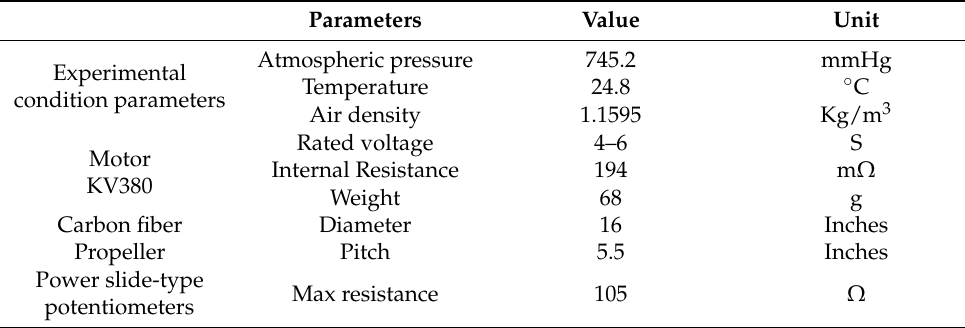
Table 3. Test conditions and parameters of the components used in the experiment.